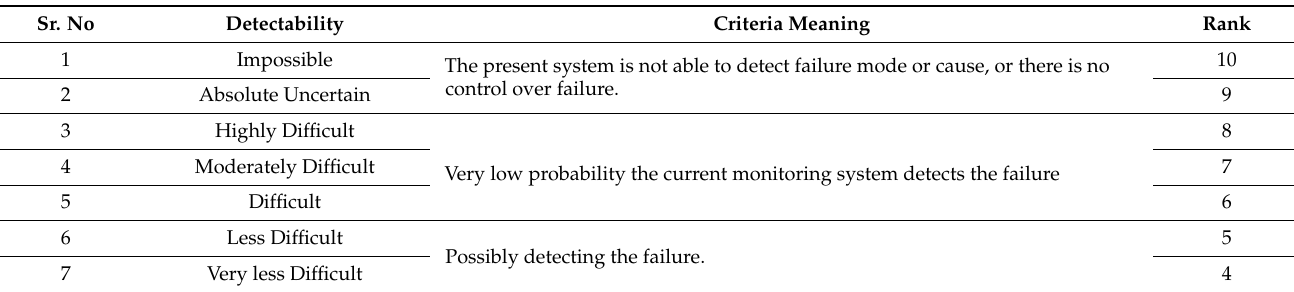
Table 3. FMECA scale to rate detection